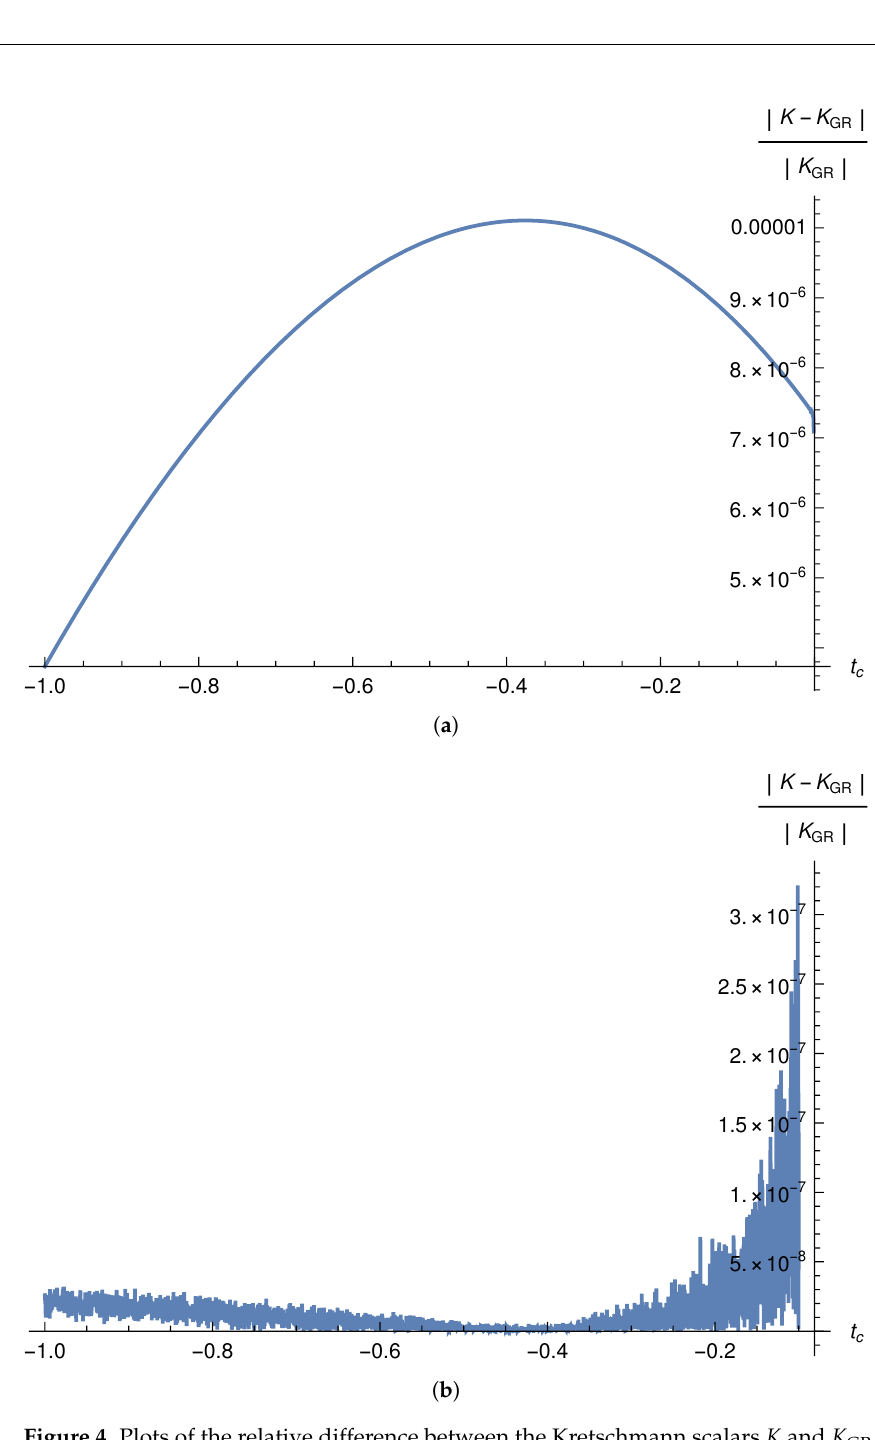
) is the corresponding Kretschmann c